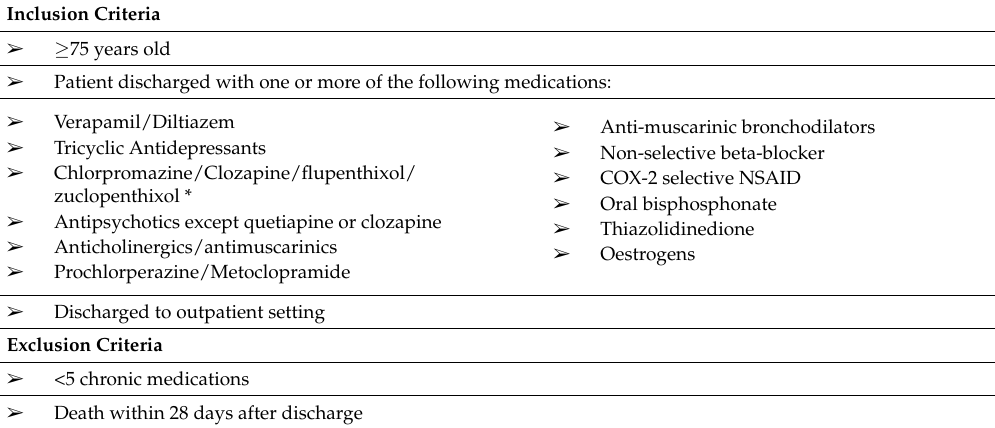
Table 2. Data collected from medical record screening.